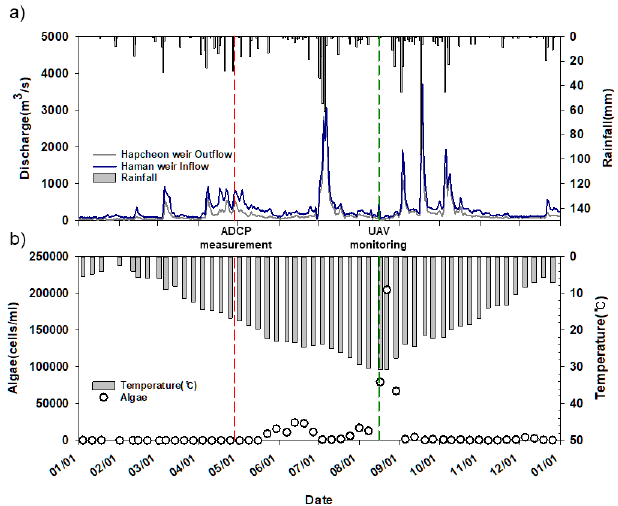
Figure 2. In situ conditions during the ADCP measurement and UAV monitoring campaigns from the various perspectives of ( a ) streamflow discharge and rainfall (at the outflow of Hapcheon weir and inflow of Haman weir) and ( b ) temperature and algal concentration in 2016.